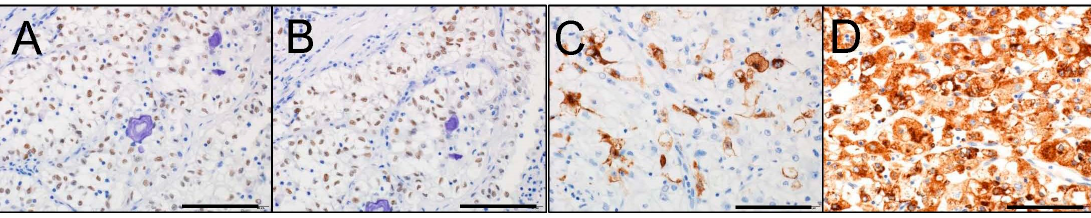
Figure 2. Immunohistochemistry of MiT family tRCC. ( A ) TFE3 staining for Xp11 tRCC, ( B ) TFEB staining for t(6;11) RCC, ( C ) HMB45 staining for t(6;11) RCC, and ( D ) Cathepsin K staining for t(6;11) RCC. Scale bar, 100 µm.